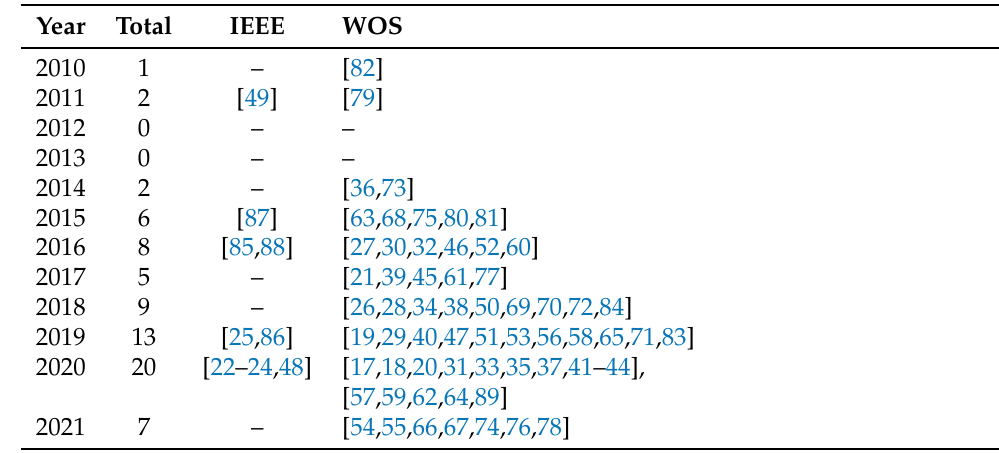
Table 6. Articles per year and